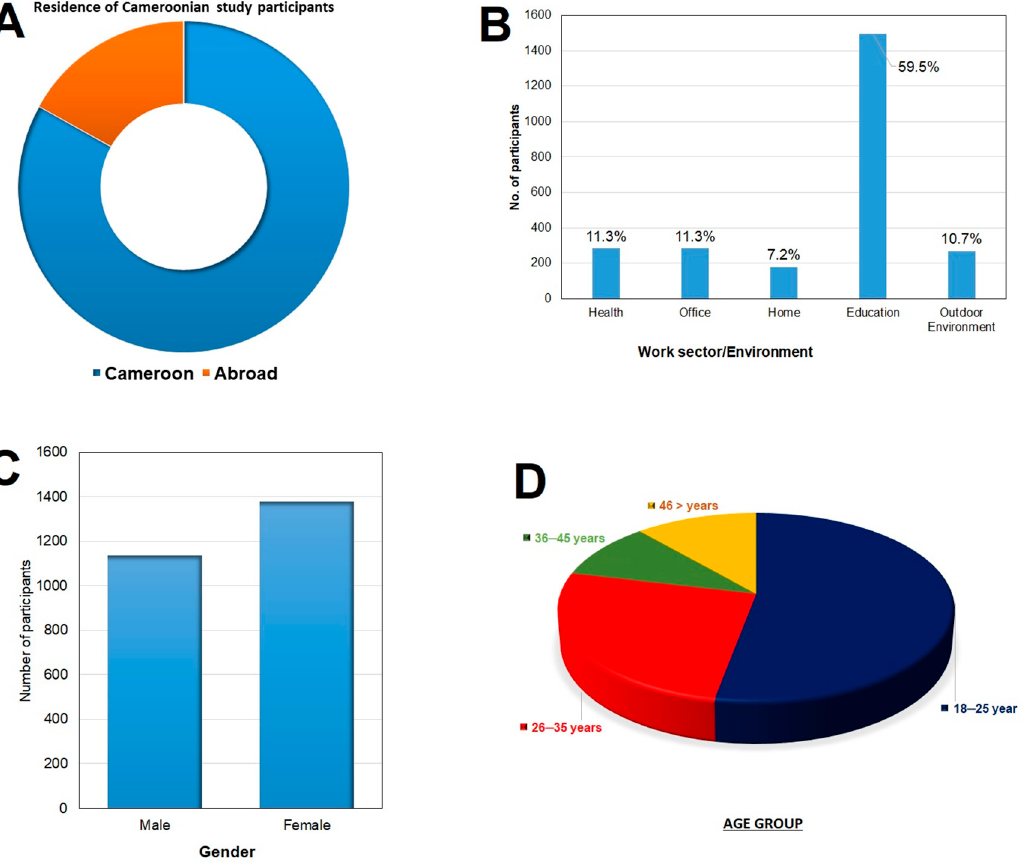
Figure 2. Demographic information of study participants. ( A ) most of the participants were residing in Cameroon while 17% of them lived out of the country. ( B ) Those working in the education sector constituted more than half of the participants. ( C ) shows the percentage males and females ( D ) shows the age of the participants with a majority of them being between the ages of 18–25.